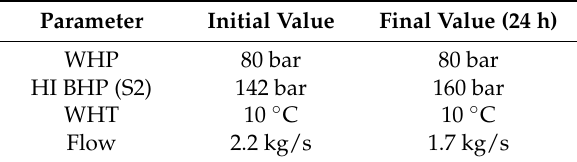
Figure 4. The evolution of the operating parameters of the 24-hour CO 2 injection in the pressure control mode (80 bar WHP). The BHP from the HI sensors ( HI BHP S1/S2 ), the WHP in the injection well, the BHP from the sensor located in the seal of the HA well ( HA BHP S1 ) and the flow rate of brine and CO 2 . The initial and final values of the operating parameters for the injection are shown in Table 3. Table 3. The operating parameters for 24-hour CO 2 injection in pressure control mode.